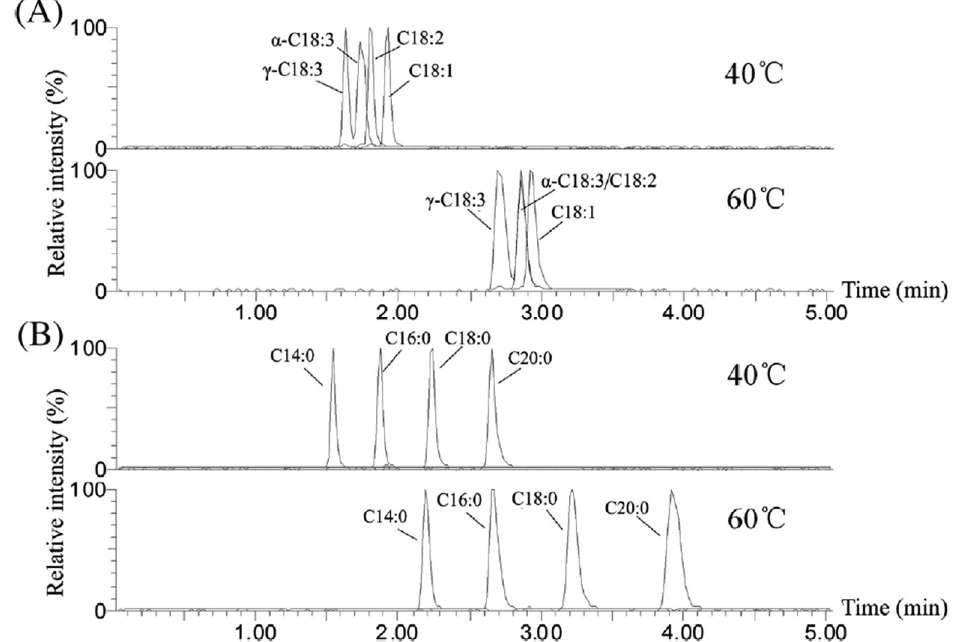
Figure 4. Reconstructed ion chromatograms on the HSS C18 SB column (Waters) at different column temperatures: ( A ) unsaturated standard free fatty acid mixture and ( B ) saturated standard free fatty acid mixture [21], with